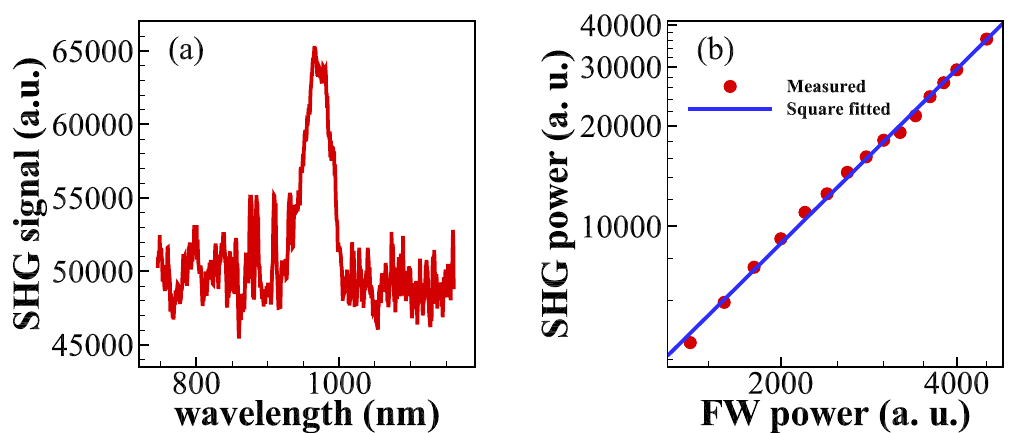
Figure 5. ( a ) SHG signal excited using 1960 nm FW laser. ( b ) Square power dependence of the SHG signal on the FW laser